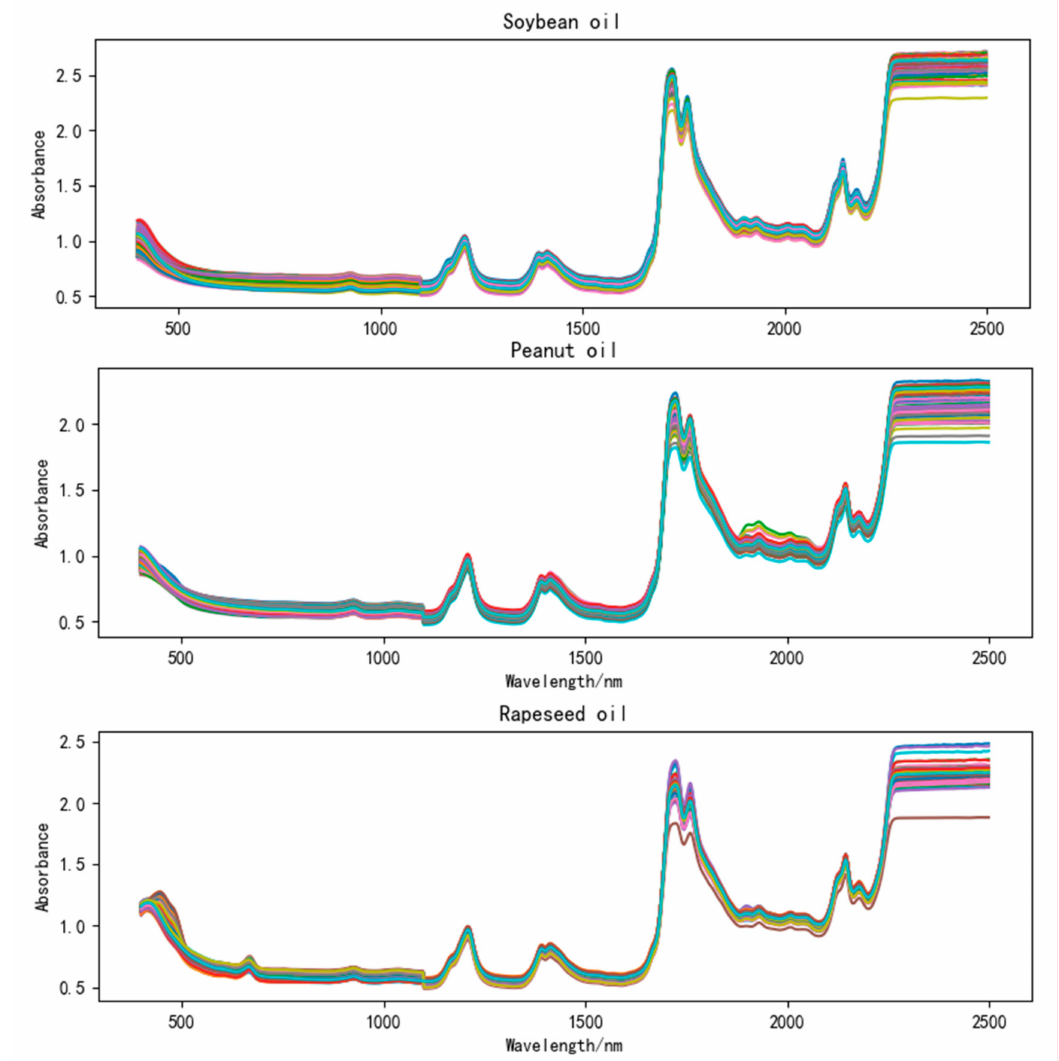
Figure 1. Original spectra of soybean oil, peanut oil, and rapeseed